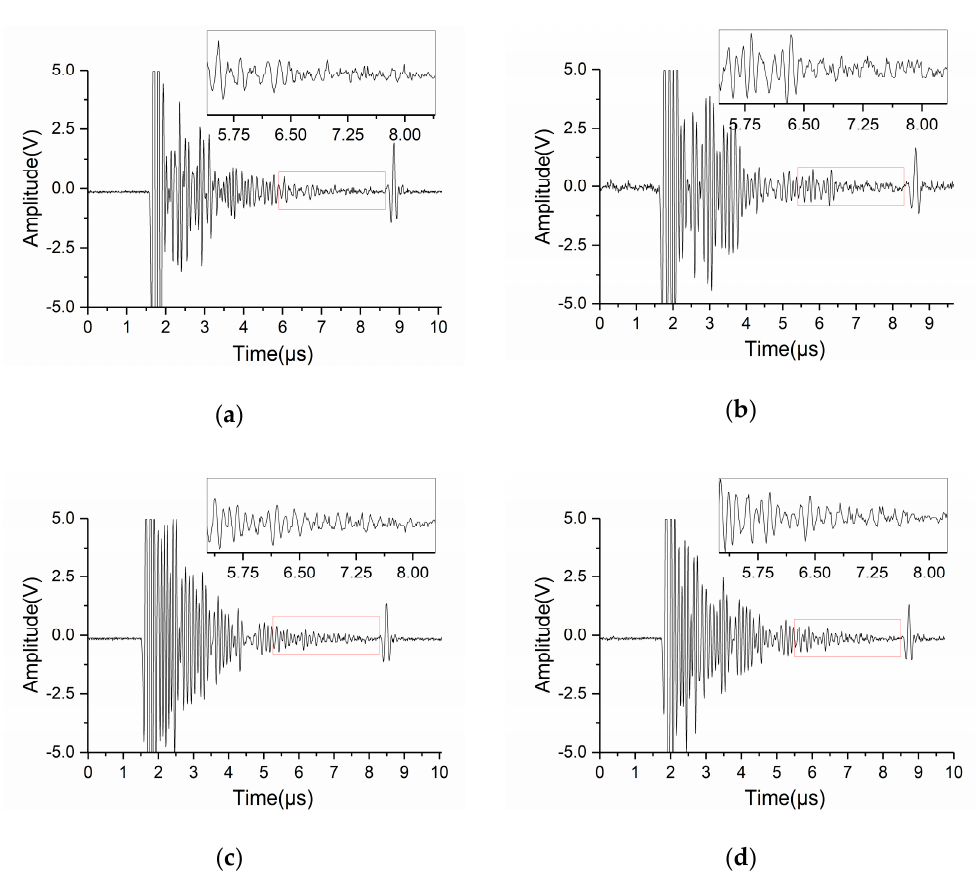
Figure 11. Ultrasonic signals of defect areas with different diameter: ( a ) 0 mm; ( b ) 0.5 mm; ( c ) 0.7 mm; and, ( d ) 1 mm.